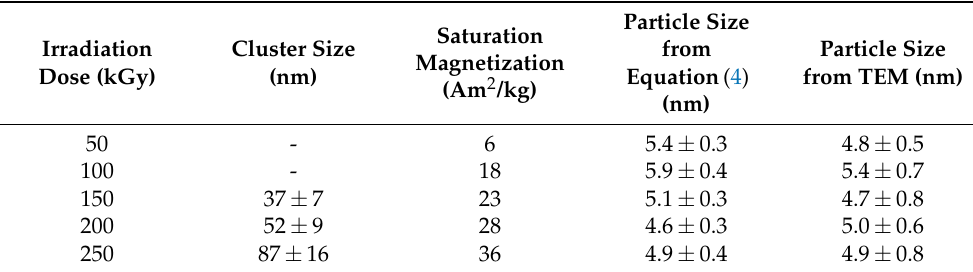
Table 1. Cluster size, saturation magnetization and particle diameter obtained from fitting and from TEM images for different doses.